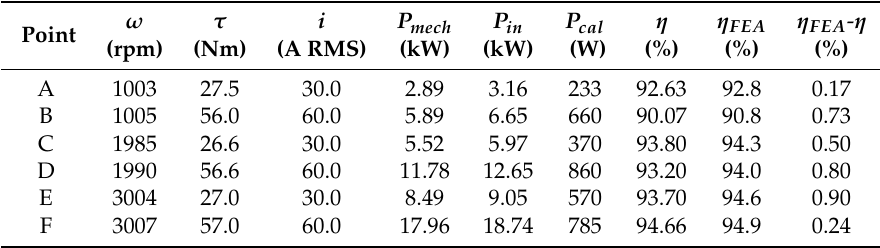
Table 7. Results from calorimetric